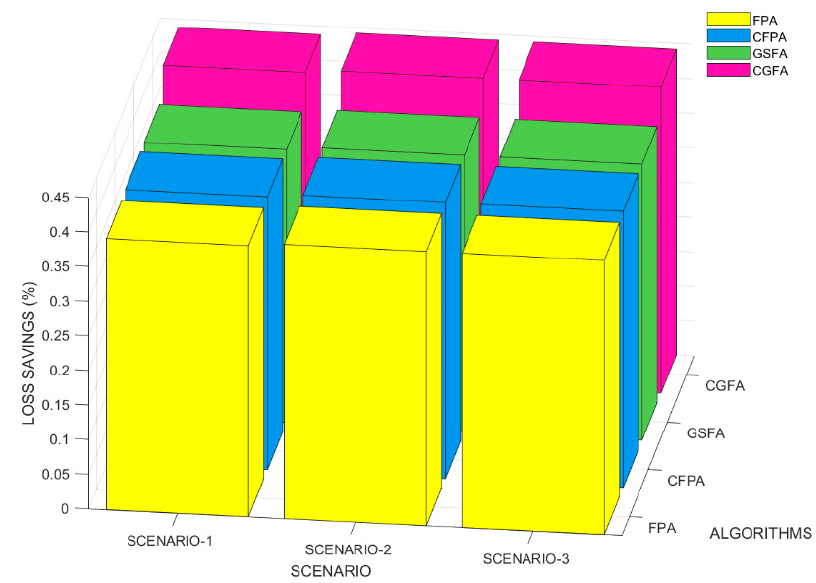
Figure 8. Percentage loss savings of different algorithms in an IEEE 69-bus system.